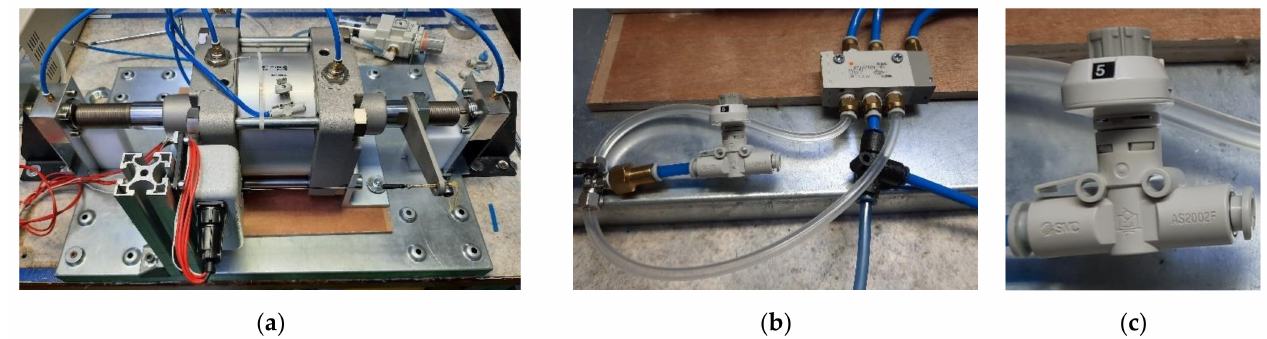
Figure 12. Testbed for functional tests of the prototype of the pneumatic oscillator: ( a ) overall view; ( b ) detail of the exhaust line of the 5/2 pilot valve; ( c ) detail of the flow